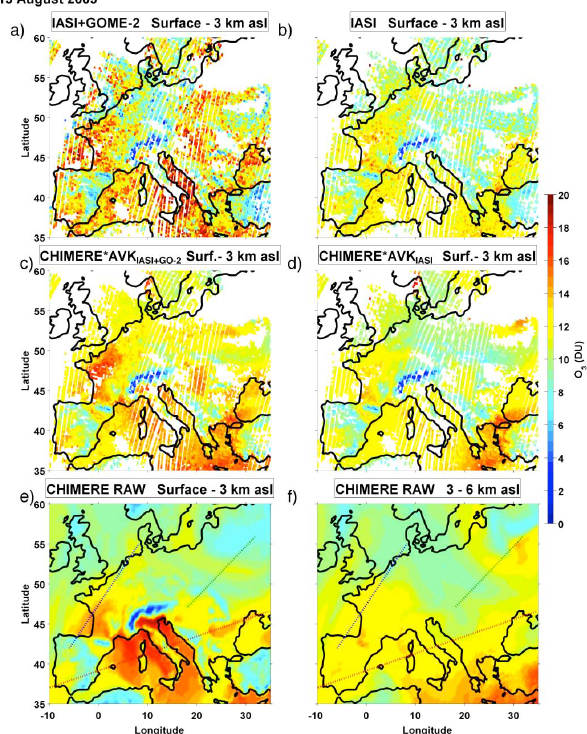
Fig. 10. Ozone observations (DU) in the lowermost troposphere (LMT, up to 3km a.s.l.) from (a) IASI+GOME-2 and (b) IASI only over Europe on 19 August 2009. CHIMERE model out- puts in the LMT (up to 3km a.s.l.) smoothed by the AVKs of (c) IASI+GOME-2 and (d) IASI only. CHIMERE raw outputs (e) in the LMT and (f) integrated between 3 and 6km a.s.l. ( e and f ). The dashed lines indicate the location of the northwestern (blue), northeastern (green) and southern (red) transects in Fig. 12.